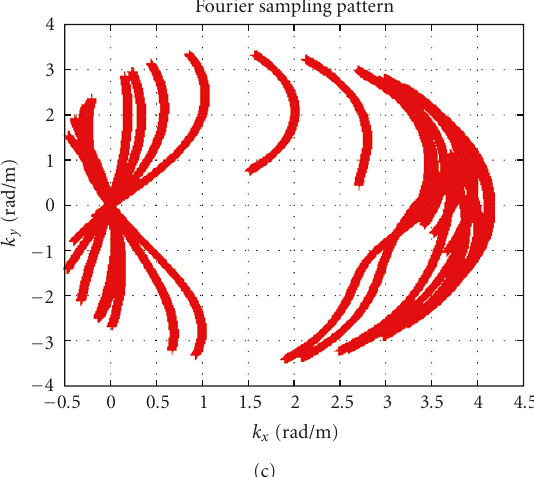
Figure 11: Fourier plan of MIISAR result for Case 4 (a), Case 5 (b), and Case 6